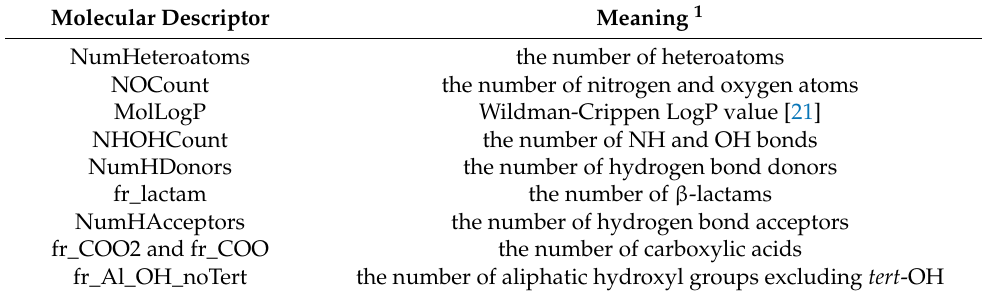
Figure 3. Importance of the top 50 molecular descriptors obtained by the RF method for the free- form dataset ( a ) and the in-blood-form dataset ( b ). Table 1. Nine descriptors with clear chemical meaning obtained by the random forest method.